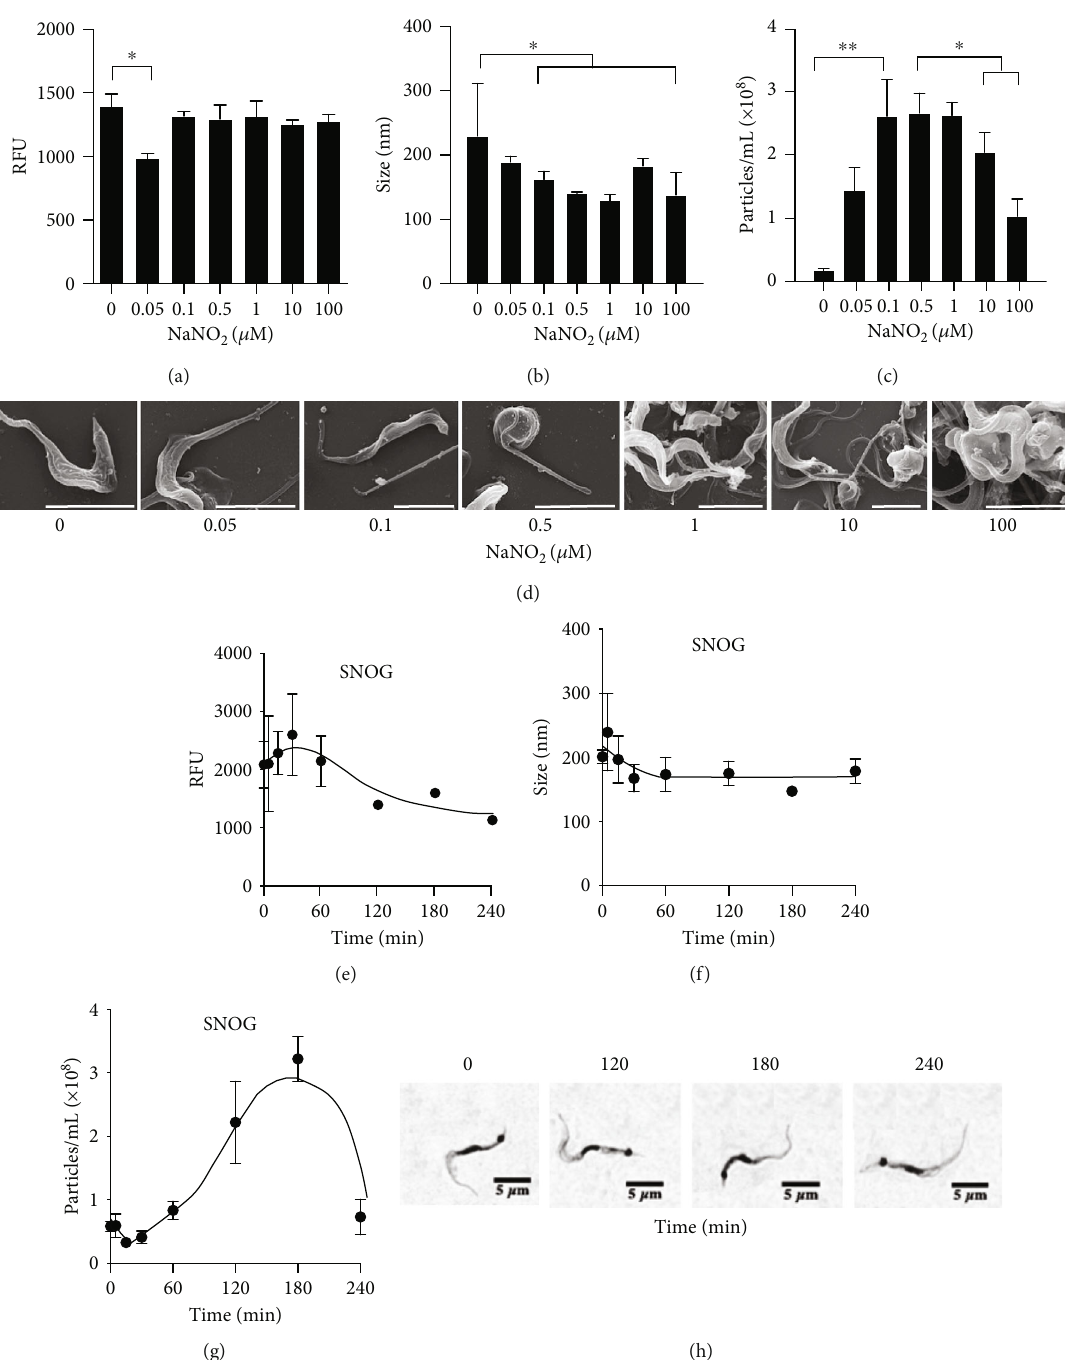
Figure 4: E ff ect of nitrosative stress on EV release by T. cruzi trypomastigotes. 1 × 10 7 trypomastigotes were incubated for 2h at 37 ° C in culture medium adjusted to pH 5.0 with di ff erent concentrations of NaNO including the control with the salt. After the incubation 2, period, cell viability was evaluated by the PrestoBlue assay(a) and EV size (nm) (b) and EV concentration (particles/mL) (c) were measured by NTA ( ∗ p < 0 : 05 and ∗∗ p < 0 : 01 ). SEM of trypomastigotes releasing EVs incubated under di ff erent NaNO concentrations 2 (d). Size bars = 5 μ m. Alternatively, trypomastigotes were incubated at 37 ° C in DMEM supplemented with 5% glucose containing 100 μ M SNOG. Parasite viability was evaluated at the indicated intervals by PrestoBlue assays (e), and the size (f) and concentration (g) of EVs in the supernatants were determined by NTA ( n = 3 ). Panel (h) shows pictures of parasites stained by Giemsa after each incubation